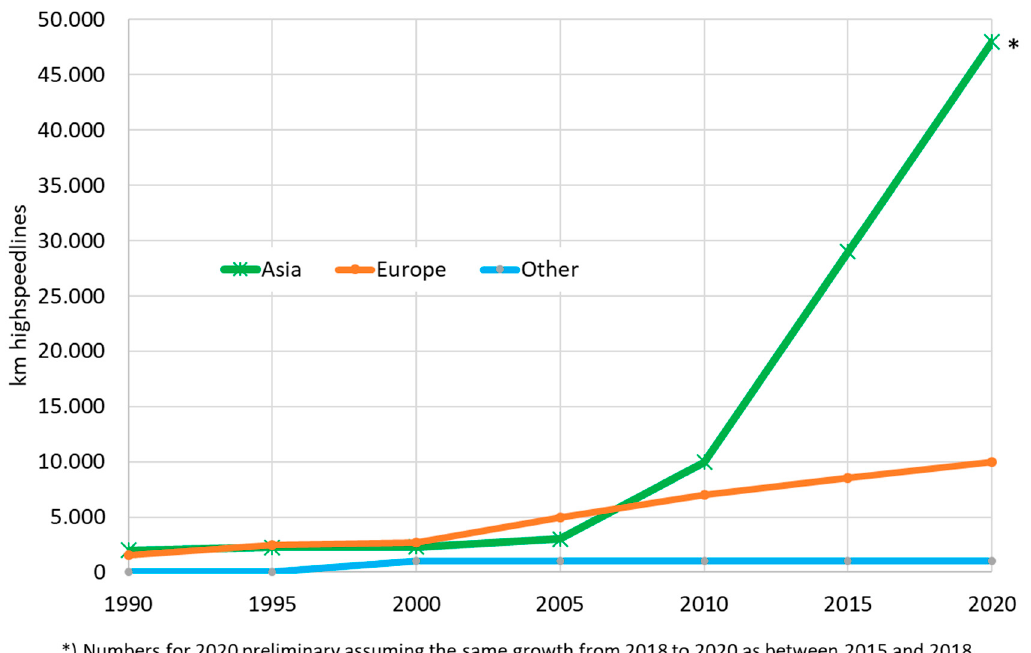
Figure 6. The development of high-speed train network lengths in the period 1990 to 2020 (own analysis, [24]).